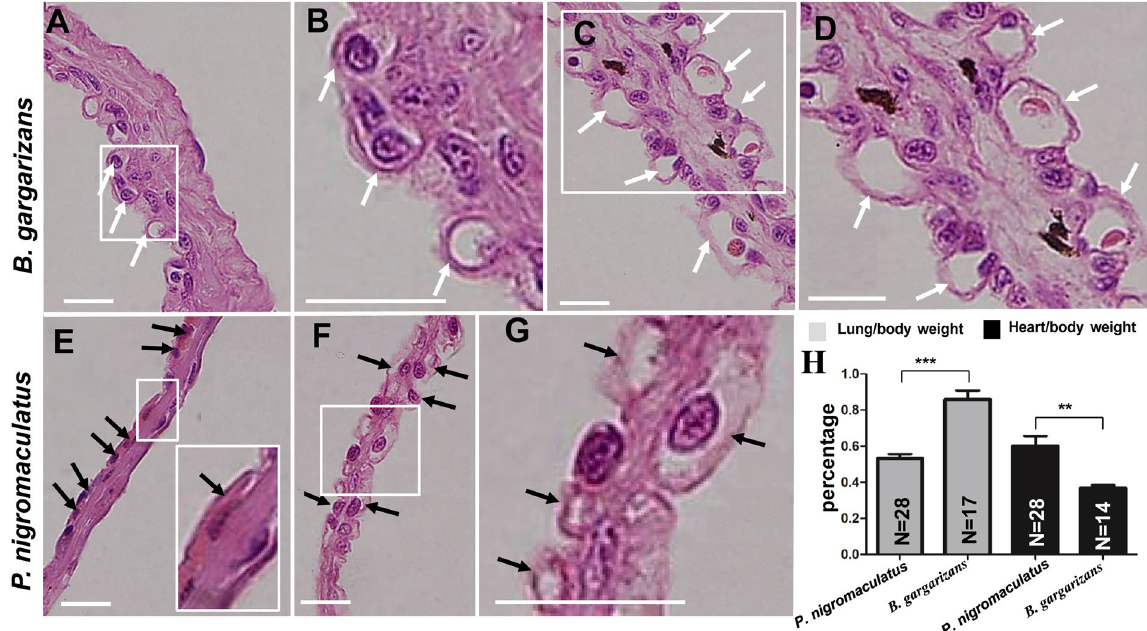
Figure 6. Structure of pulmonary capillary in B. gargarizans and P. nigromaculatus by LM. LM observation of the pulmonary capillaries in B. gargarizans and P. nigromaculatus . The pulmonary wall contains one layer of capillaries in B. gargarizans ( A,B ) and P. nigromaculatus ( E ) and is thicker in B. gargarizans ( A ) than in P. nigromaculatus ( E ). The septa contain two layers of capillaries in B. gargarizans ( C,D ) and P. nigromaculatus ( F,G ) and is thicker in B. gargarizans than in P. nigromaculatus . Lung/body weight percentage and heart/body weight percentages in B. gargarizans and P. nigromaculatus ( H ). The white arrow shows the capillary or thick fold of the lattice, and the black arrow shows the capillary or sheet of the lattice. B, D, and G show enlarged images of the boxes in A, C, and F, respectively. Scale bar: 30 μ